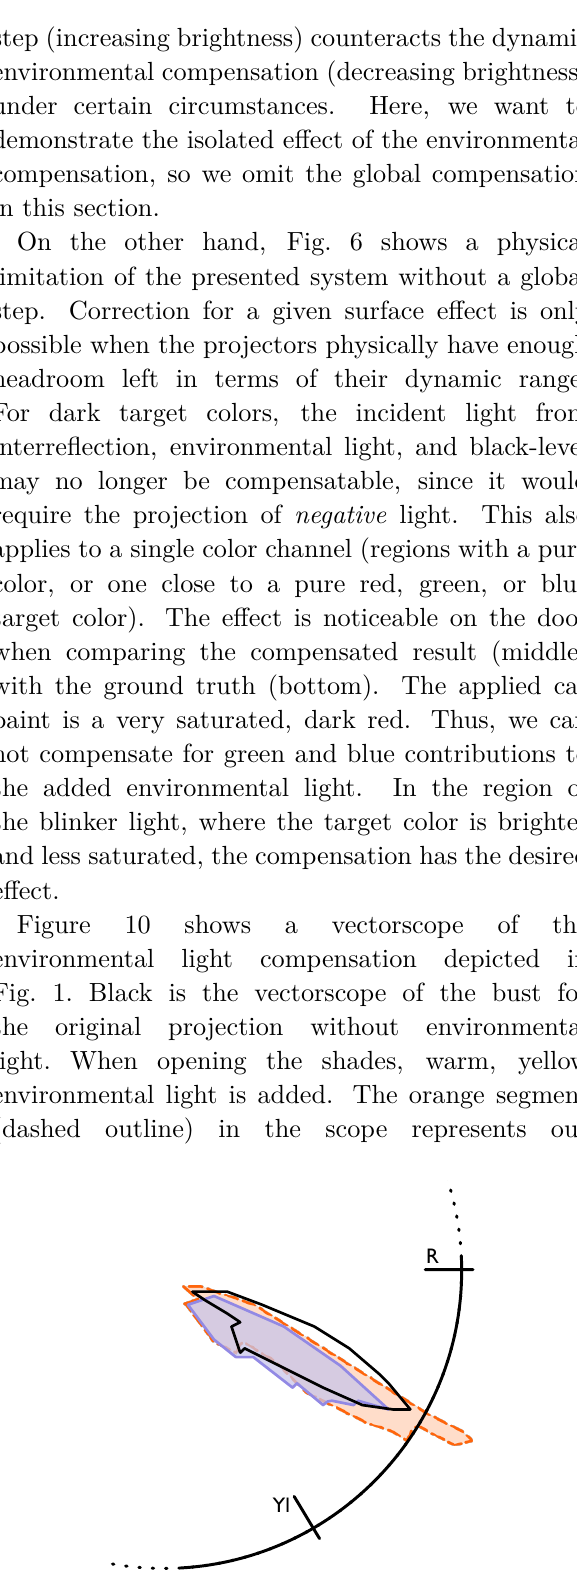
Fig. 10 The vectorscope for a projection without (black), uncompensated (orange, dashed), and compensated (blue) environmental